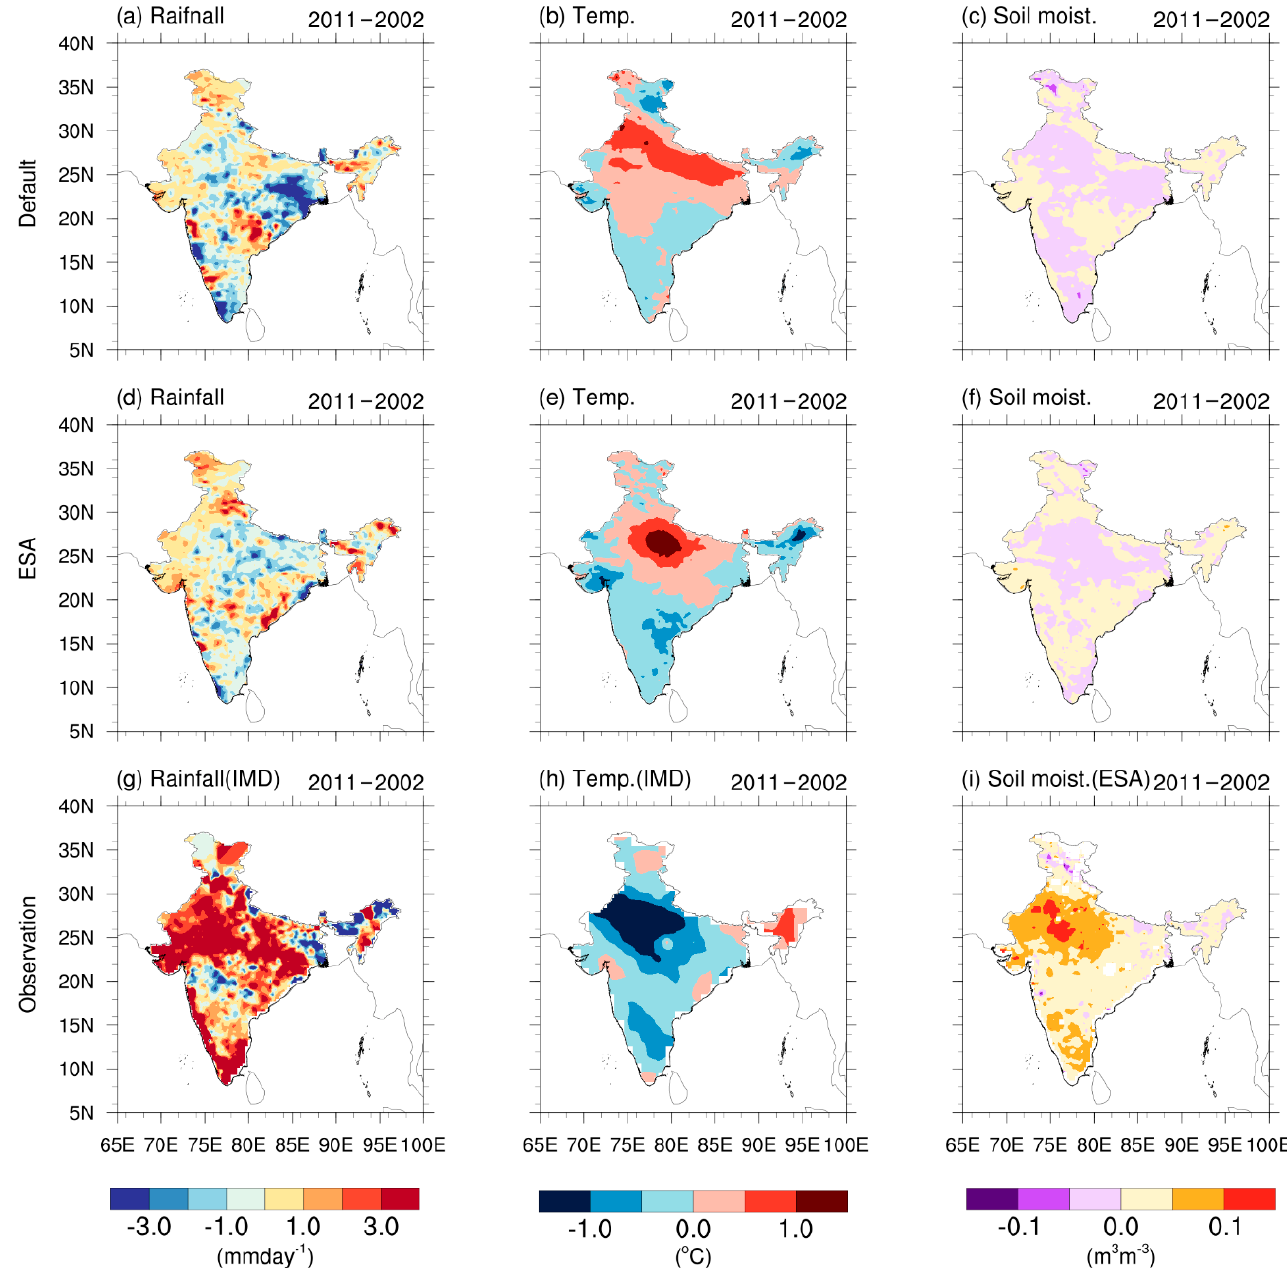
Figure 12. JJAS mean difference (2011–2002) of rainfall (1st column), surface temperature (2nd column) and soil moisture (3rd column). Rows represent the results from simulation with ( a – c ) default setup, ( d – f ) ESA setup and ( g – i ) observation.